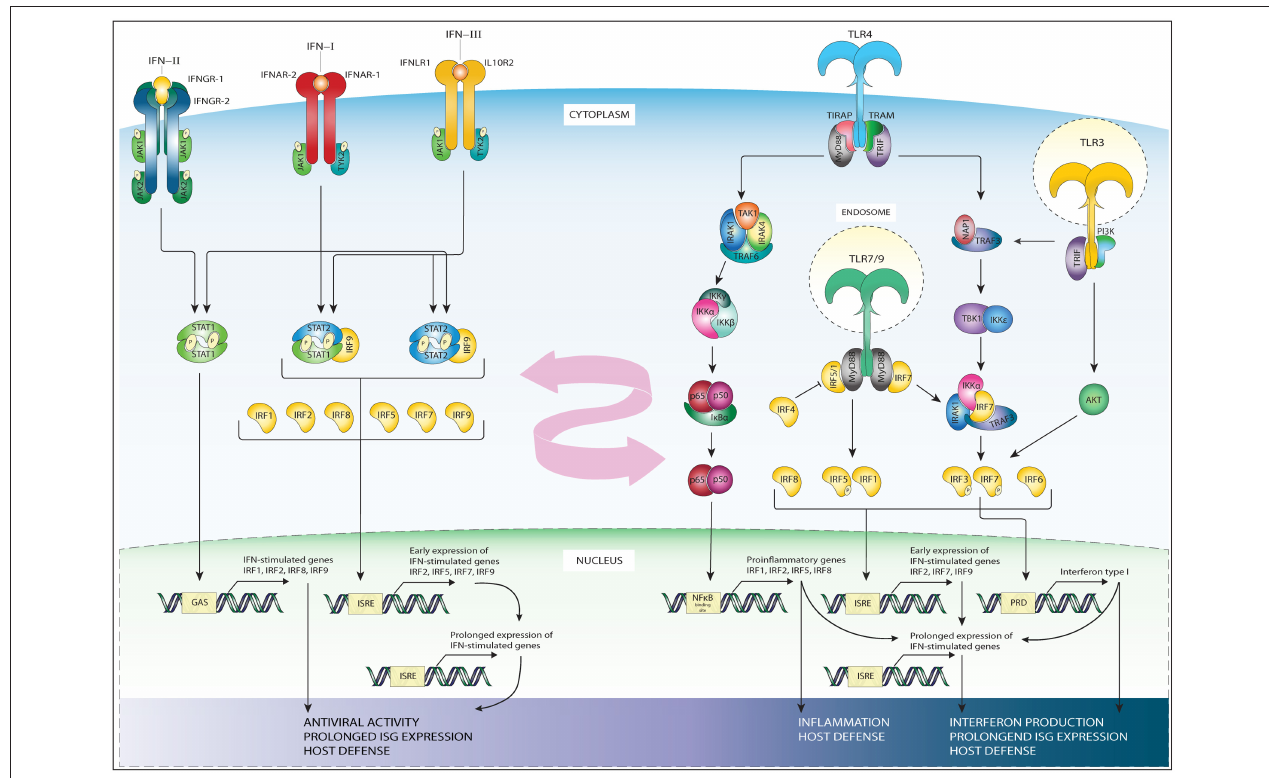
FIGURE 2 | Schematic representation of IRFs in the TLR and IFN pathways . The three subfamilies of IFN signal through distinct receptors: IFN-II signals via a receptor which consist of two interferon gamma receptor (IFN γ R)-1 and two IFN γ R-2 chains (first left). IFN-I signal via the IFNAR receptor expressed in nearly all cell types and tissues (second left). IFN-III subfamily uses the interferon lambda receptor consisting of IL10R2 and IFNLR1 (third from left). While the signaling of IFNAR and IFN-lambda relies on phosphorylation of JAK1 and tyrosine kinase 2 TYK2, the interferon gamma receptor triggers STAT signaling via phosphorylation of JAK1 and JAK2. IFN-II specifically triggers STAT1 homodimer formation (most left), while IFN-I and IFN-III trigger ISGF3, (second from left), or STAT2/IRF9 in absence of ISGF3 (third of left). These complexes translocate to the nucleus to bind DNA on recognition sequences (GAS or ISRE, see bottom-left). The initial IFN stimulation leads to the early expression of ISGs and the transcription of IRF1/5/7/8/9 and STAT1, STAT2. The accumulation of newly synthesized transcription factors leads to a secondary, prolonged wave of ISG expression (bottom-left), contributing to antiviral activity and host defense. TLR4 signaling occurs through a MyD88-dependent (middle-right) and MyD88 independent (right) signaling cascade. In the MyD88 dependent signaling MyD88 recruits IRAK4 and IRAK1 leading to their phosphorylation, which in turn associates IRAK with TRAF6. TRAF6 activates TAK1, which in turn leads to phosphorylation of IKK α / β . The phosphorylation of these proteins results in their degradation and enables the translocation of NF- κ B to the nucleus where it binds NF- κ B binding sites (middle-right). The MyD88 independent signaling activates TRIF, which in turn via IKK ε and TBK1 signaling phosphorylate IRF3 and IRF7 at their C-terminal serine/threonine cluster (right). Upon phosphorylation these IRFs translocate to the nucleus and bind ISRE or PRD sites on the DNA. TLR3 (most-right) also signals through TRAF and IRF3, or via the PI3K-Akt pathway. TLR7 and 9 signaling (right, down) goes via MyD88, TRAF, and IRF7, or via phosphorylation of IRF5. Down below in the figure the subsequent DNA recognition sites are listed, together with the general biological effects of gene activation, such as interferon production, prolonged ISG production and host defense. TLR3 and 4 signaling leads to upregulation of IFN beta, triggering the IFN-I pathway. This, together with the IRFs whose expression is upregulated by pathway activation (listed down below in the figure) provide cross-talk between the TLR and IFN pathways (pink